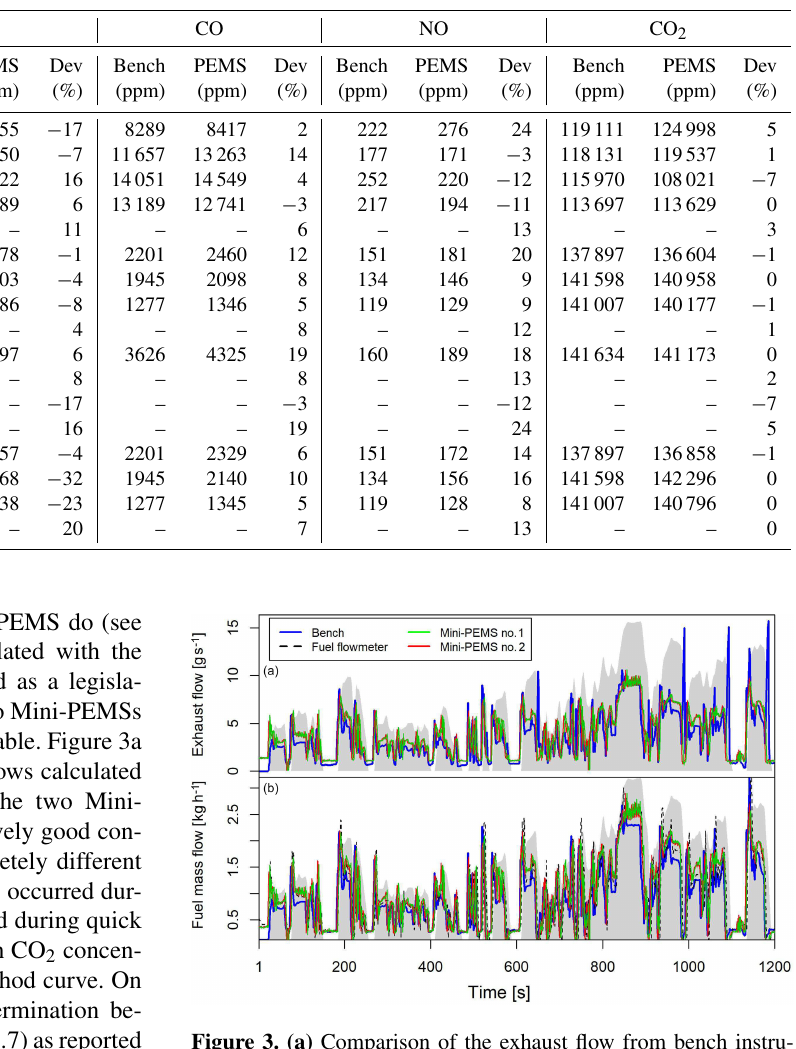
Table 4. Comparison of HC, CO, NO x , and CO 2 raw-exhaust concentrations (ppm) measured with the standard test cell instrumentation (bench) and the Mini-PEMS No.1 during legislative test cycles (WMTC and R47) and wide-open throttle tests (Vehicle 1) on the roller bench. Dev: deviation; MAPD: mean absolute percentage deviation; min/max: minimum/maximum deviations. ∗ Tests performed with additional Mini-PEMS No. 2.